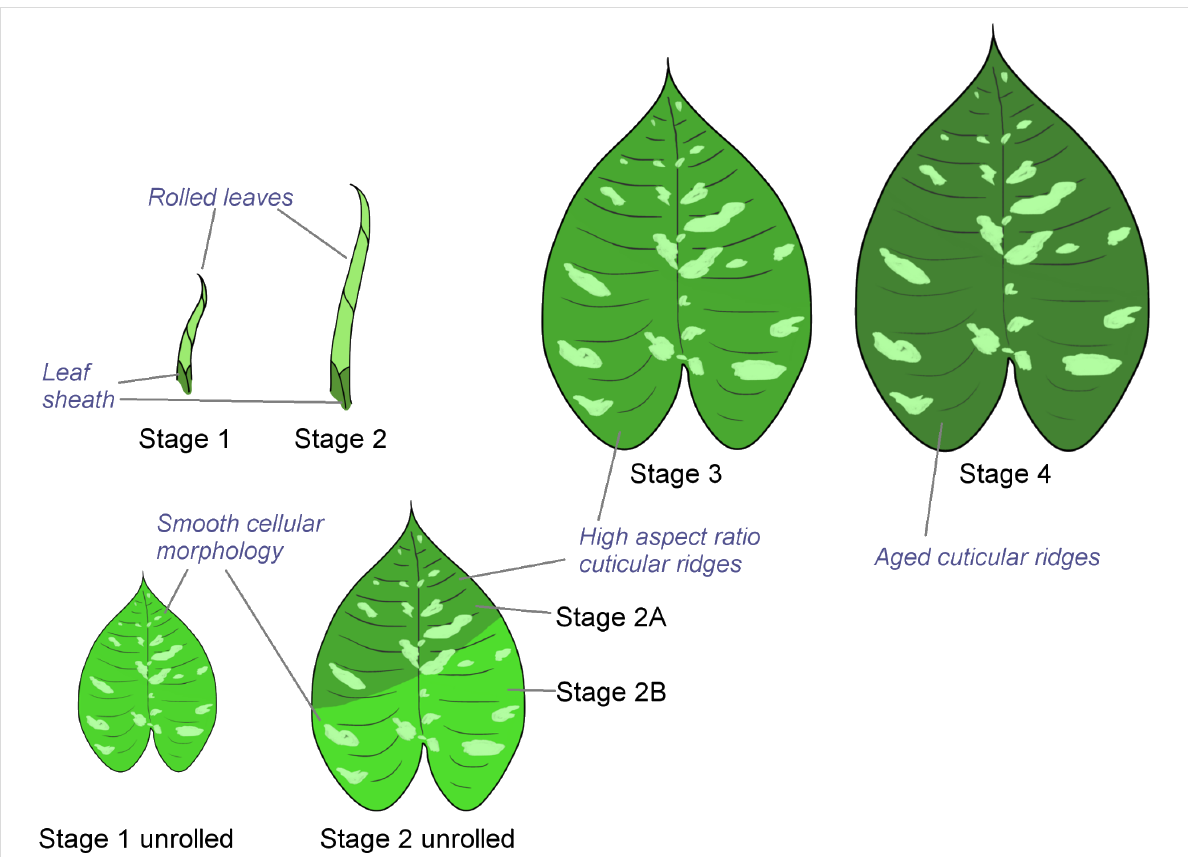
Figure 2: Schematic representation of leaf growth stages of Schismatoglottis calyptrata and their respective surface microstructures. At stages 1 and 2, leaves are normally in the rolled position. The schematics show the leaf colors when the leaves were unrolled manually.